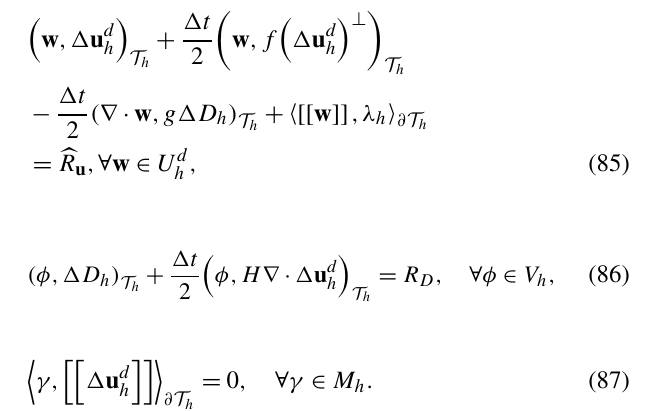
Figure 5. Breakdown of the CG k and HDG k − 1 execution times on a 6 · 64 3 simplicial